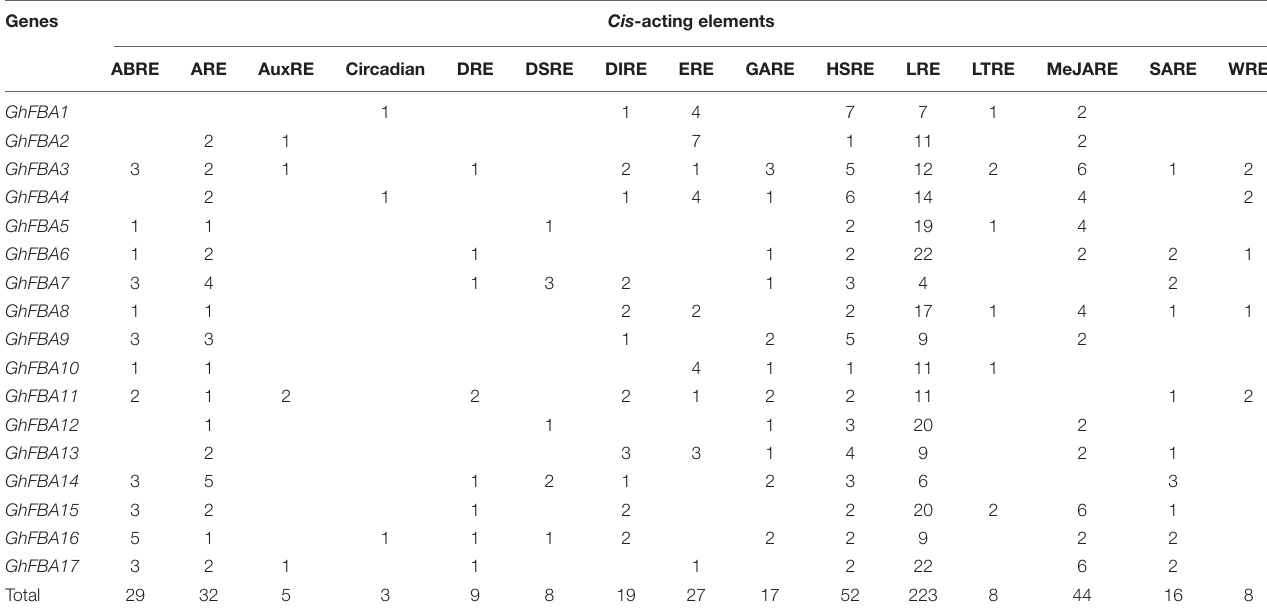
TABLE 2 | Response-related cis -acting elements in the promoter regions of GhFBA genes.